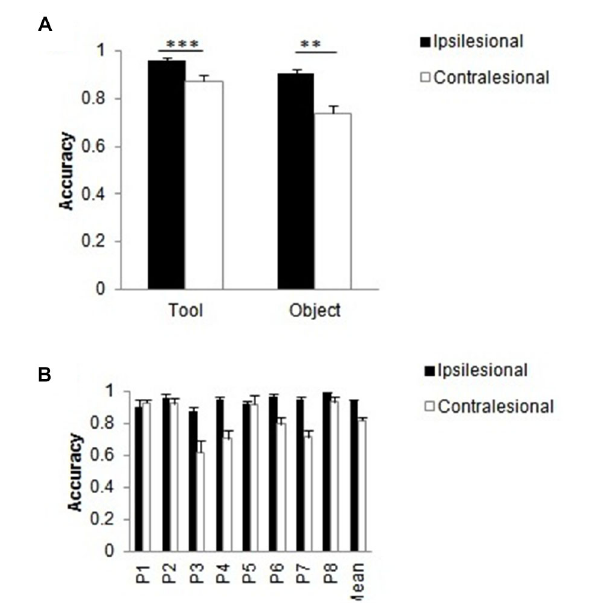
FIGURE 8 | The relation between stimulus type (tool, object) and side of stimulus (contralesional, ipsilesional) on unilateral trials. (A) Mean accuracy of performance and mean patient accuracies (B) as function of side of stimulus. Error bars denote SE. Asterisks denote significance ( ∗∗∗ p < 0.001, ∗∗ p <